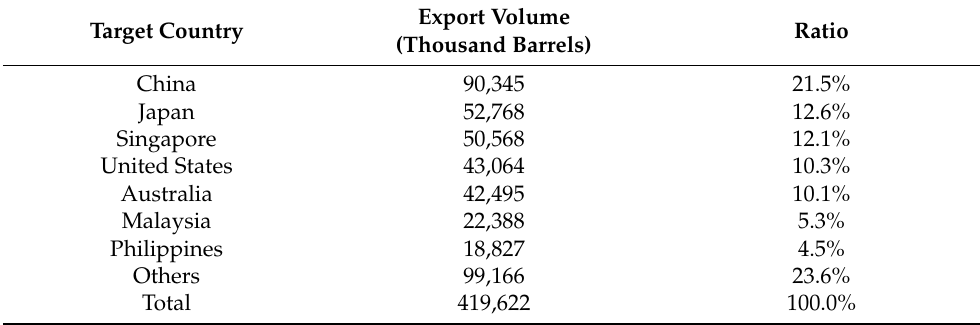
Table 2. South Korea’s petroleum product exports by country (as of 2021). Export Volume Target Country